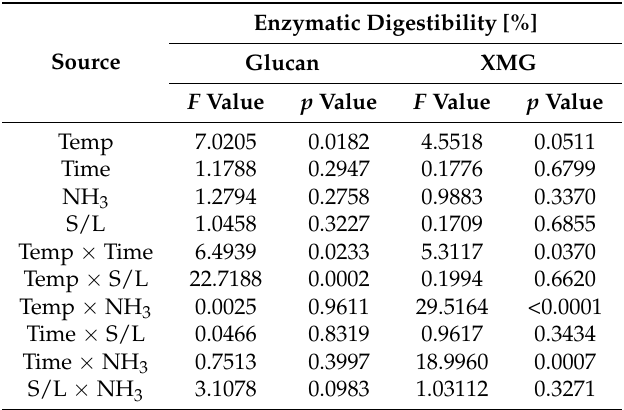
Table 3. Effects of various parameters and their combinations on glucan and XMG digestibility (ANOVA).